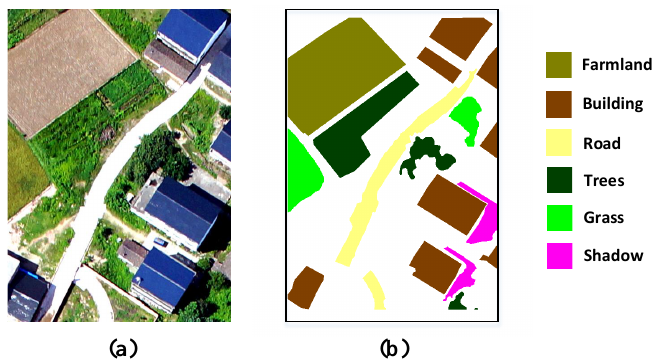
Figure 8. JX_1 data: ( a ) Image data. ( b ) Available ground-truth.